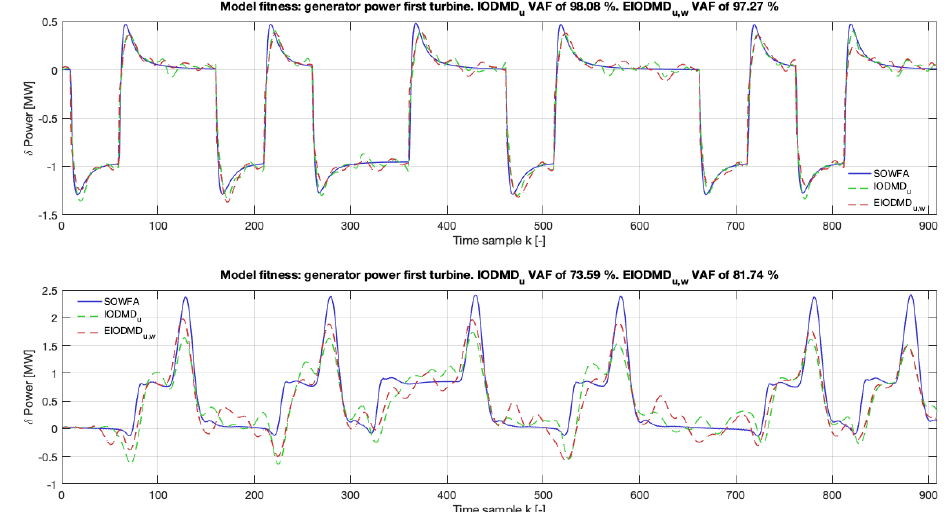
Figure 10. Comparison of IODMD u best performing model response ( dashed green line ) with the EIODMD u , w ( dashed red line ) for turbine validation data retrieved from SOWFA ( solid blue line ). Both models can also be compared based on their response in the frequency domain.